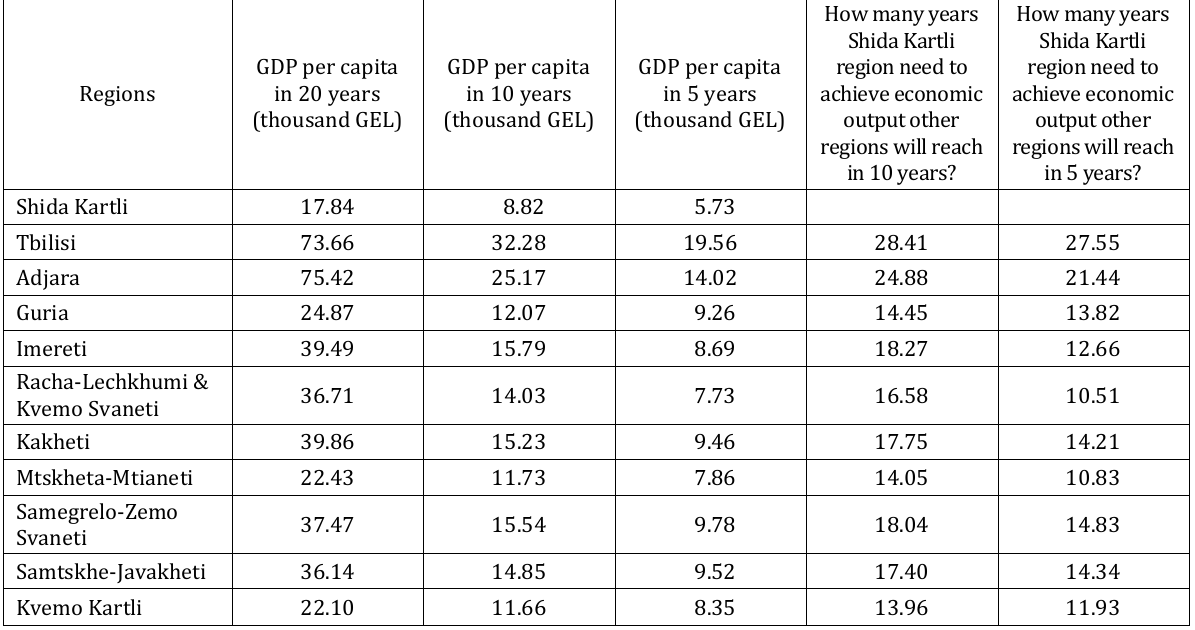
Table 3. GDP per capita forecast for the regions of Georgia in 20, 10 and 5 years and the number of years the Shida Kartli region will need to achieve the same economic output that other regions will have in 5 and 10 years (Source: own elaboration based on data from the National Statistics Office of